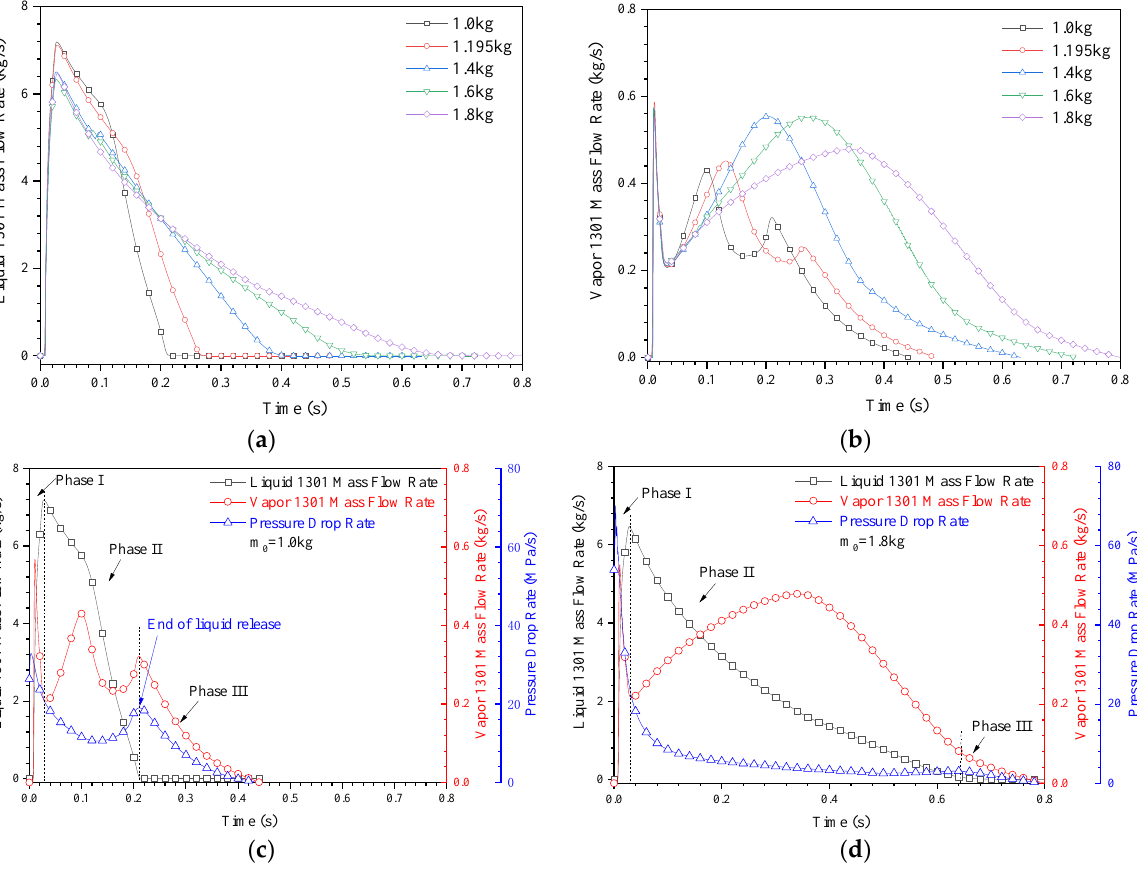
Figure 14. Mass flow rates of the extinguishing agent under different filling amounts: ( a ) liquid mass flow rates; ( b ) vapor mass flow rates; ( c ) mass flow rate and pressure drop rate under 1.0 kg; ( d ) mass flow rate and pressure drop rate under 1.8 kg.